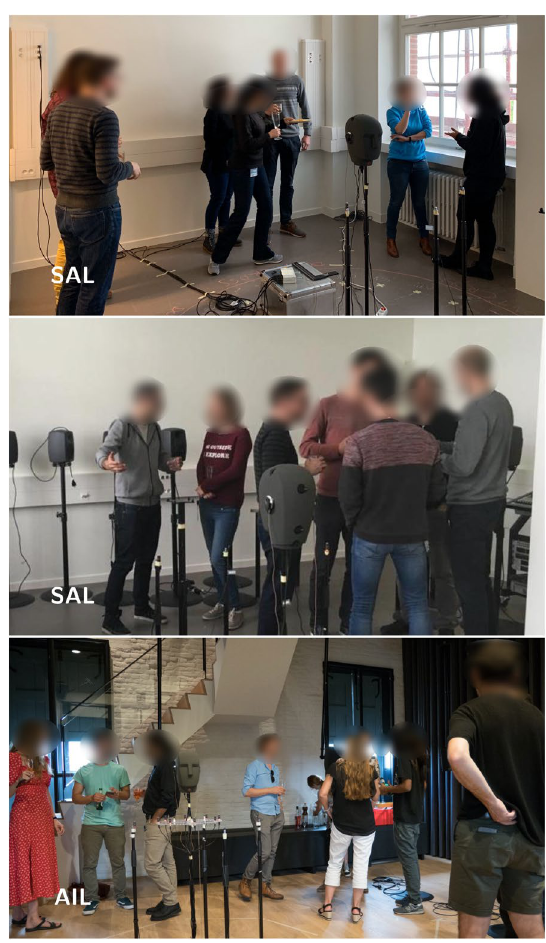
Fig. 8 Cocktail party recordings at the SAL and the